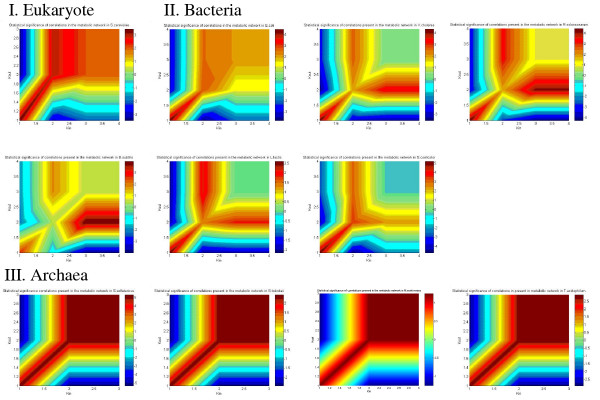
Statistical significance of correlation (Z-scores) present in the metabolic networks. To improve statistics, the connectivities in all eleven panels of this figure were logarithmically binned into two bins per decade. Statistically significant correlation profiles are generated using the Matlab program developed by Maslov and Sneppen [13].